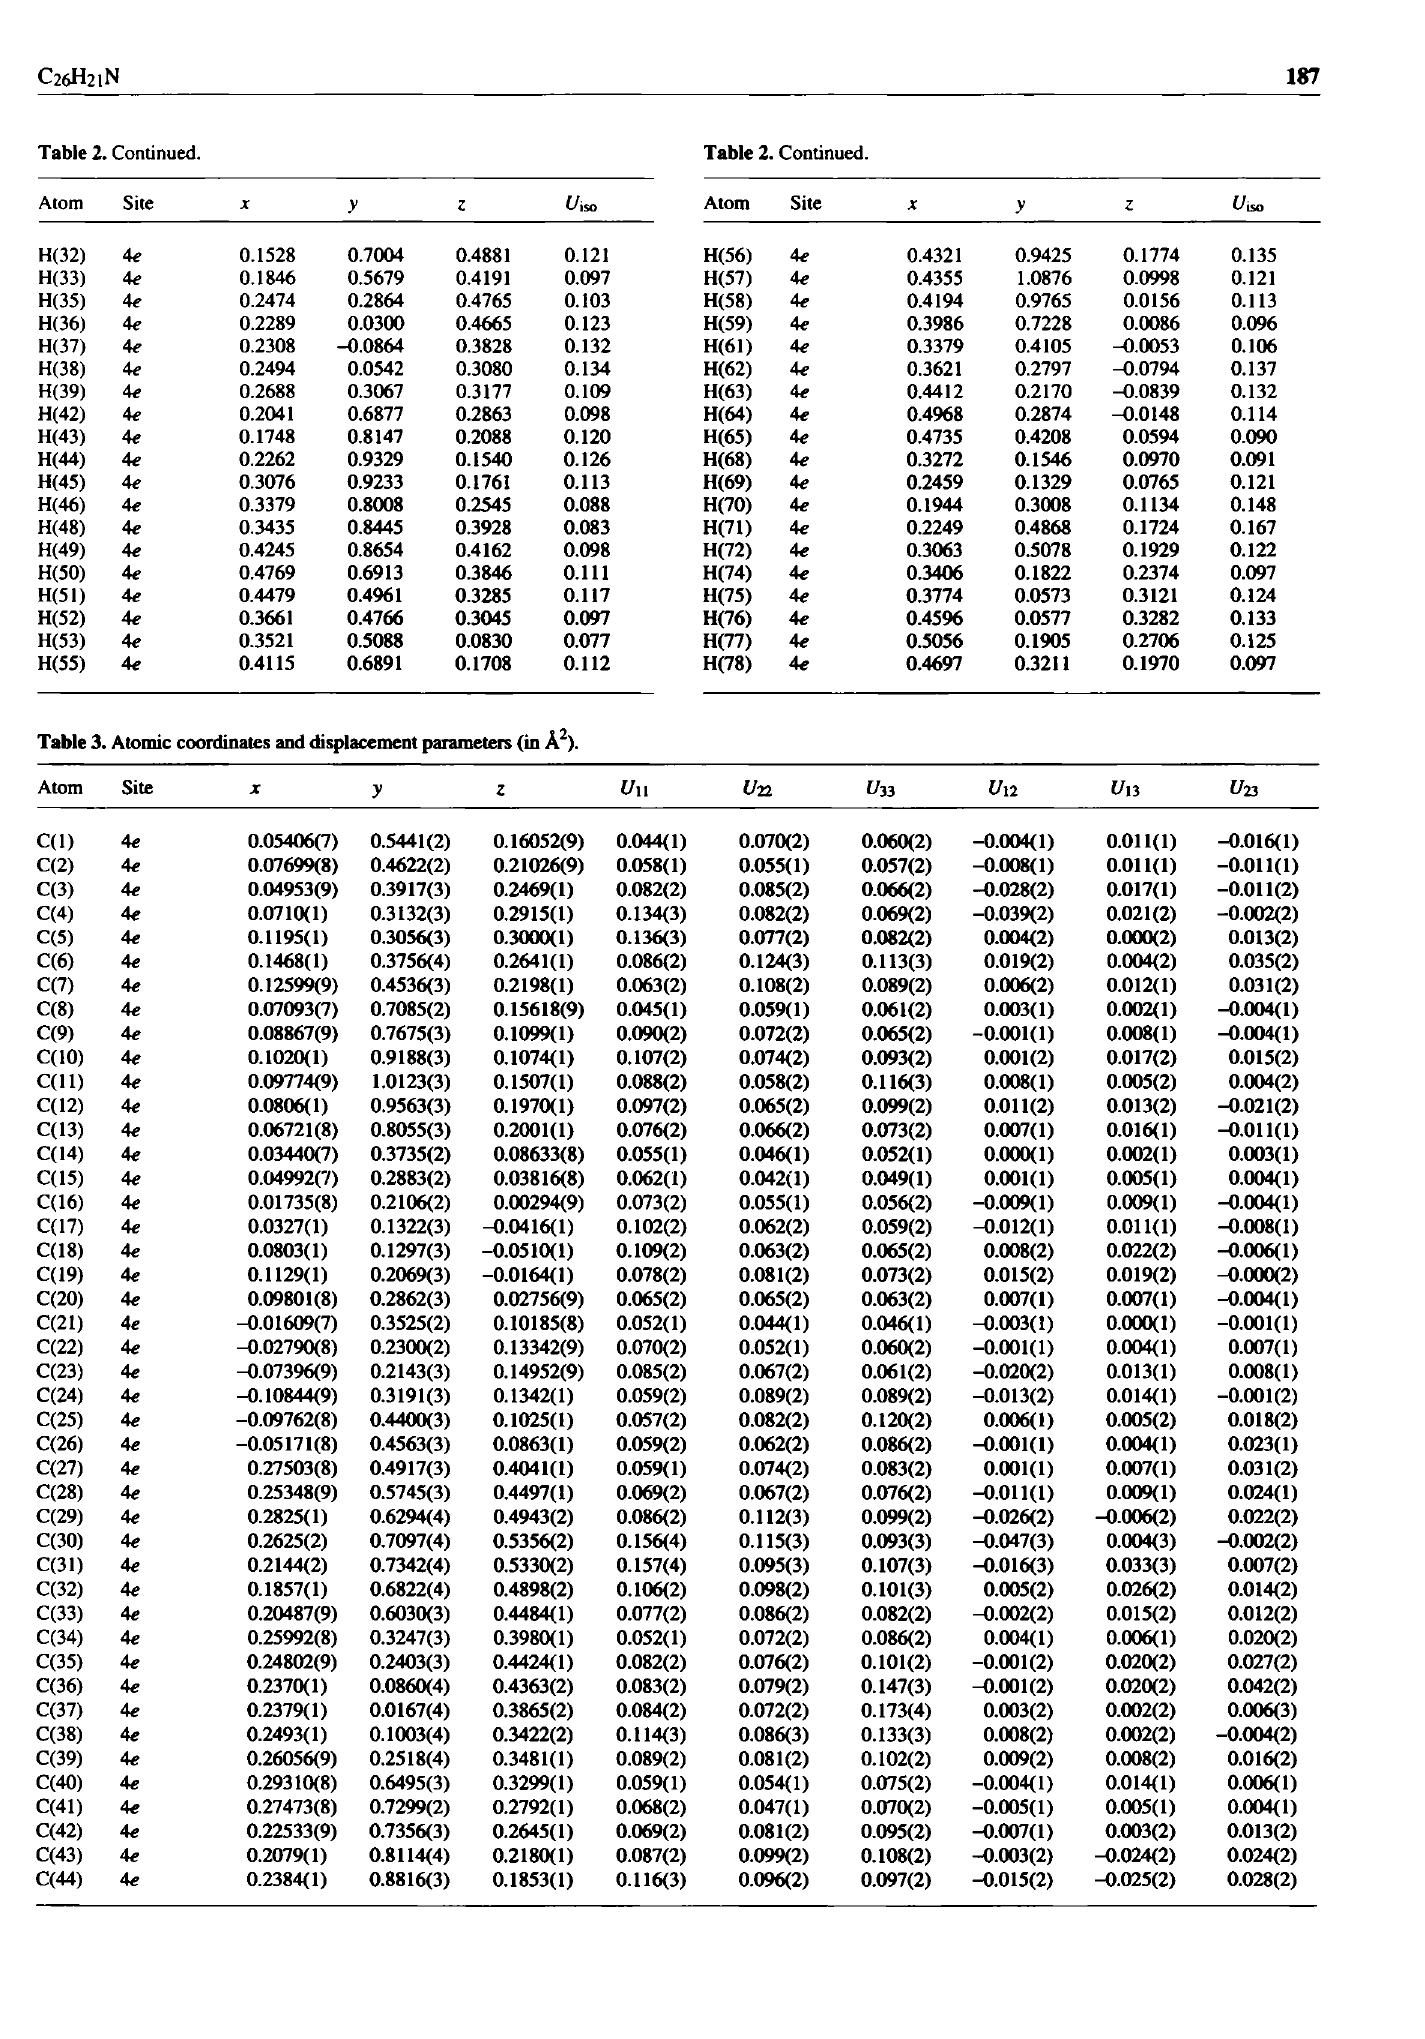
Table 3. Atomic coordinates and displacement parameters (in Â 2